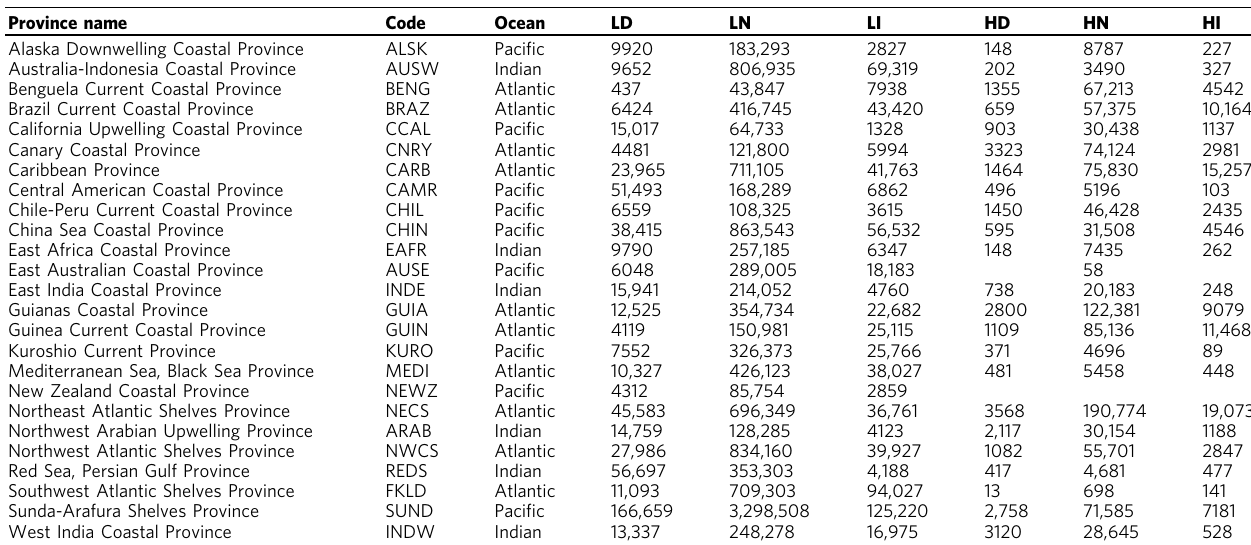
Fig. 2 Map of CEP in the global ocean and in the Bohai Sea. a Preliminary assessment of CEP in the global ocean for the period 2003 – 2019 based on MODISA global dataset. The CHL threshold is same as in Fig. 1. b Preliminary assessment of CEP in the Bohai Sea based on the YOC algorithm for the same period as in a but with spatial resolution of 1 km. c Same as b but for MODISA 1 km spatial resolution. d Same as b but for MODISA 4 km spatial resolution. The southern and northern regions with few observations (<70% in the 17-year period) were masked. The GEE App is accessible through the link https://eutrophicationwatch.users.earthengine.app/view/global-eutrophication-watch. Table 1 Global distribution of the area coverage estimates of each eutrophication potential class based on the coastal biogeochemical provinces (https://www.marineregions.org/sources.php#longhurst) as in Longhurst (2006) 43 . Total area estimate [km 2